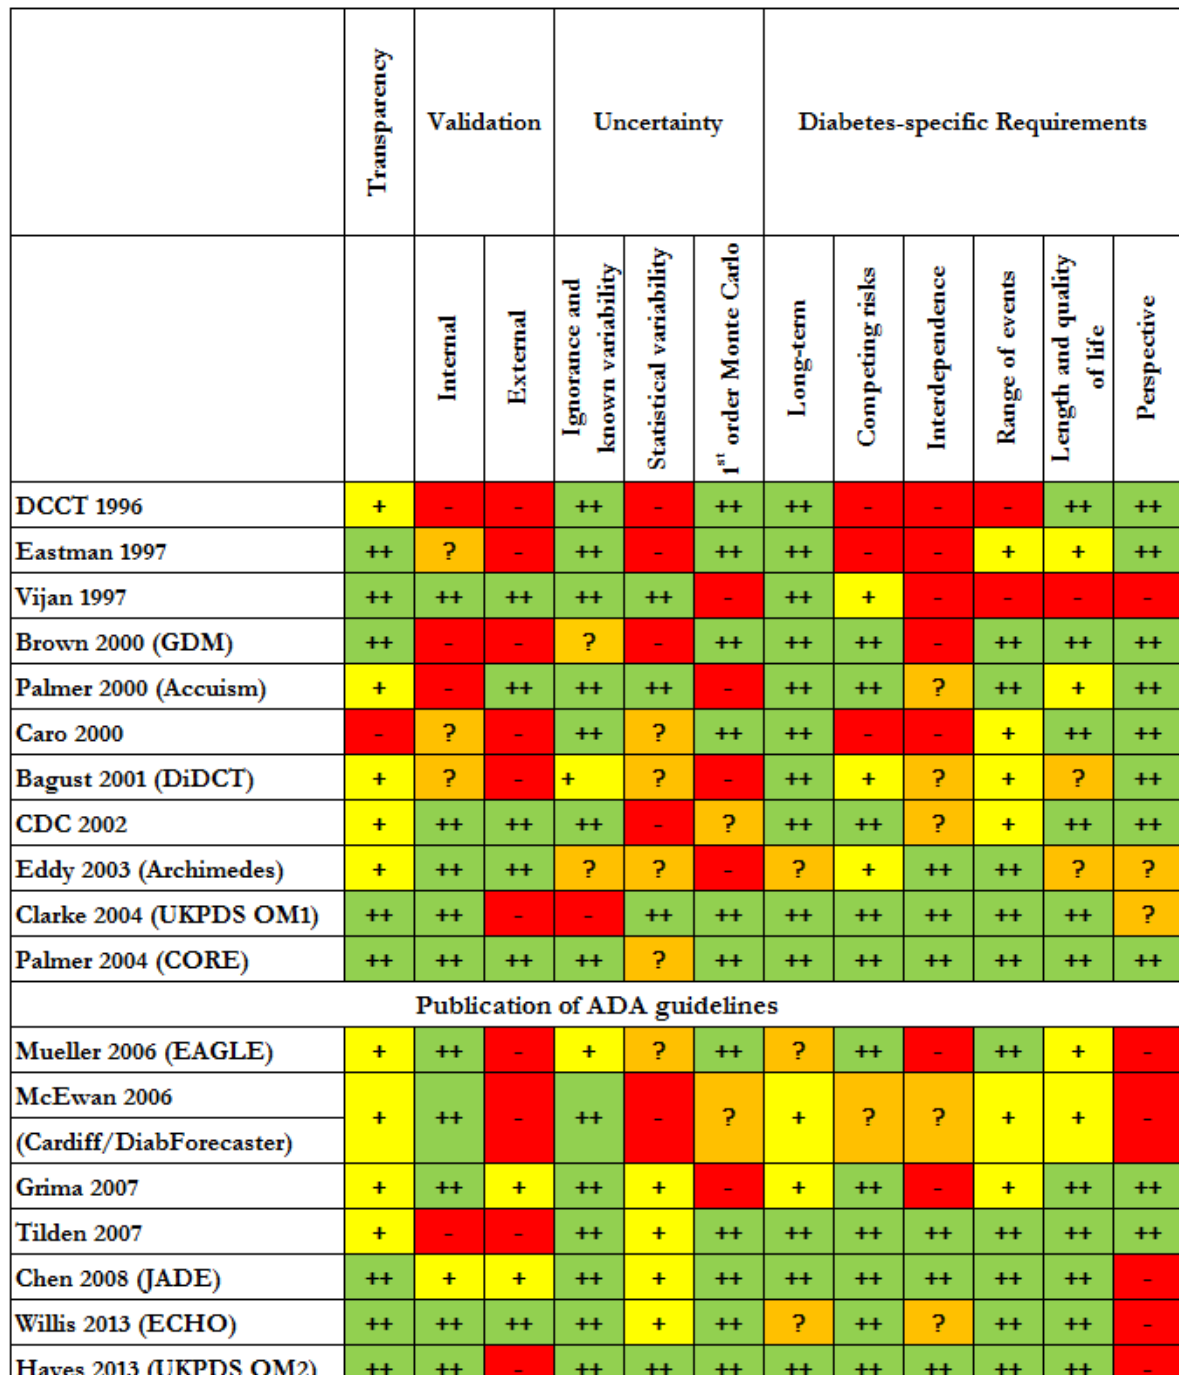
Table 2. Criteria Defined by the ADA in Reporting a Diabetes Prediction Model